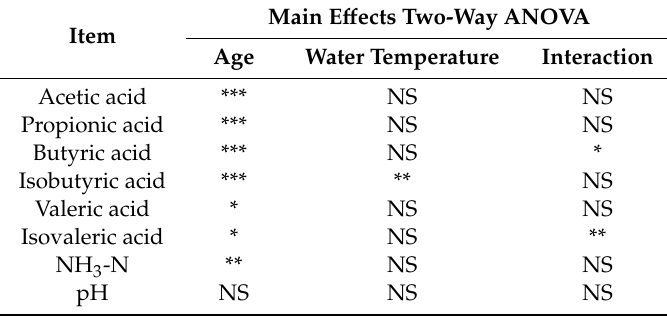
Table 2. Significant e ff ects of age and water temperature on small chain fatty acid concentration, NH 3 -N concentration, and pH values.